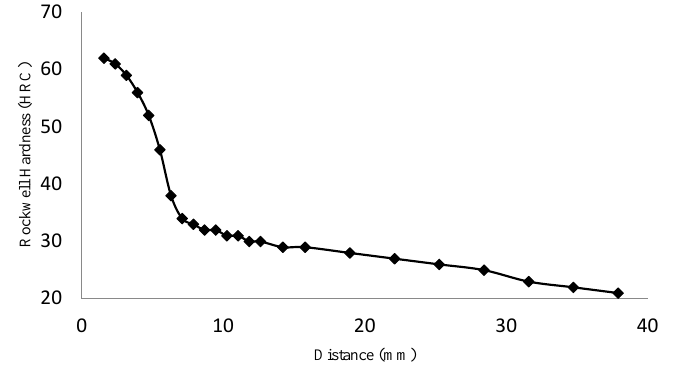
Figure 5. Volume fraction in percent and transformation per temperature for AISI 1045 steel according to 0.14 and 0.6 carbon content [8,10]. Metals 2017 , 7 , 41